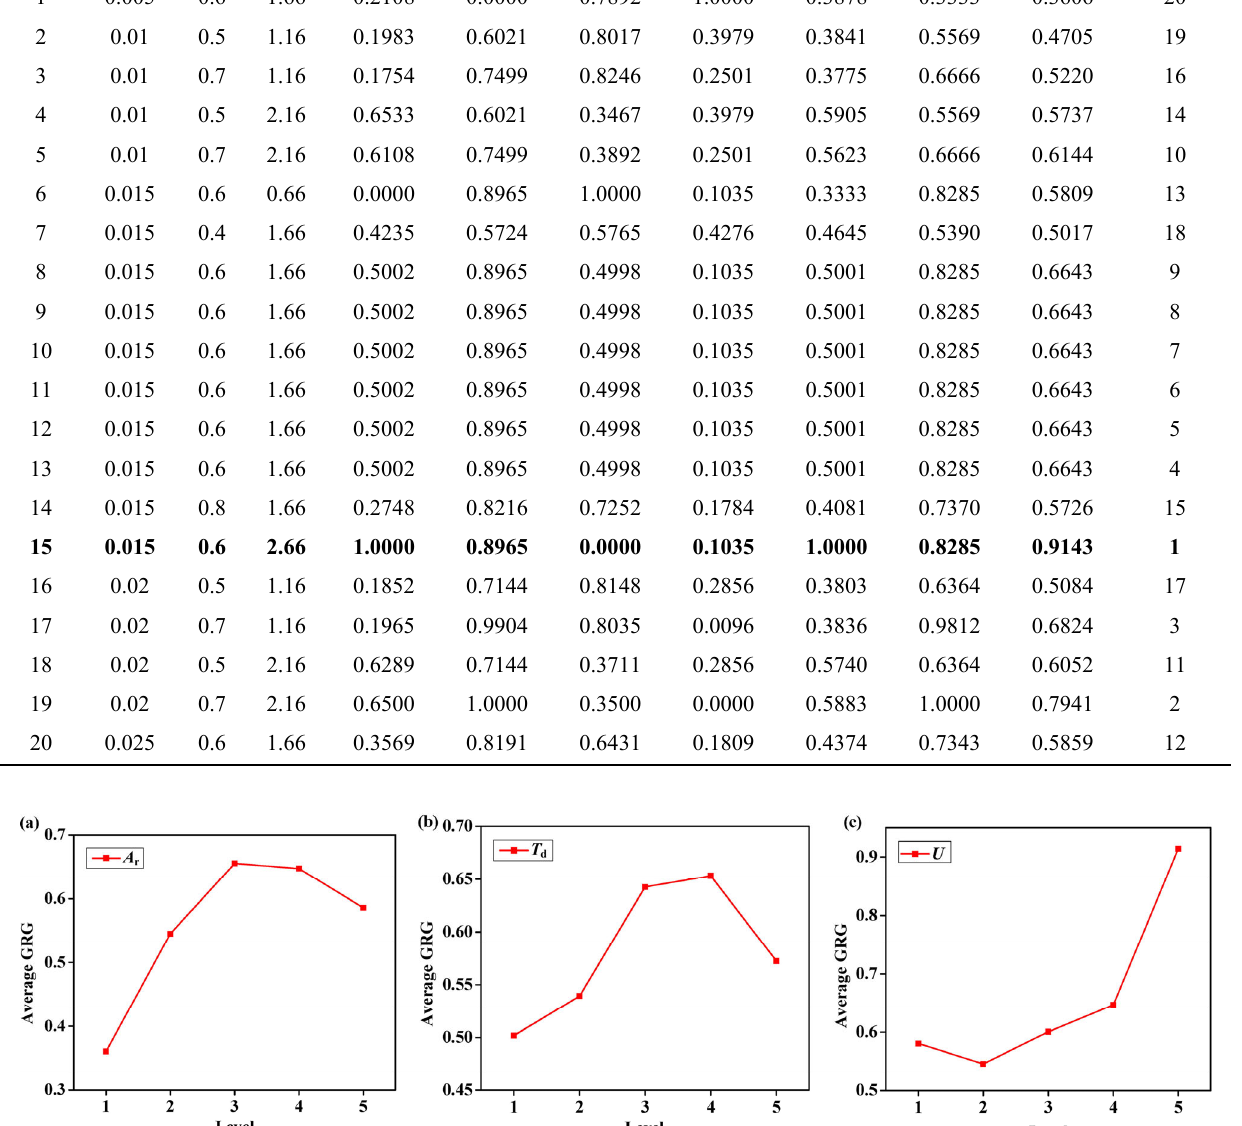
Fig. 10 Influence of flat bottom profile texture design variables (a) aspect ratio, (b) texture density, and (c) flow speed on output